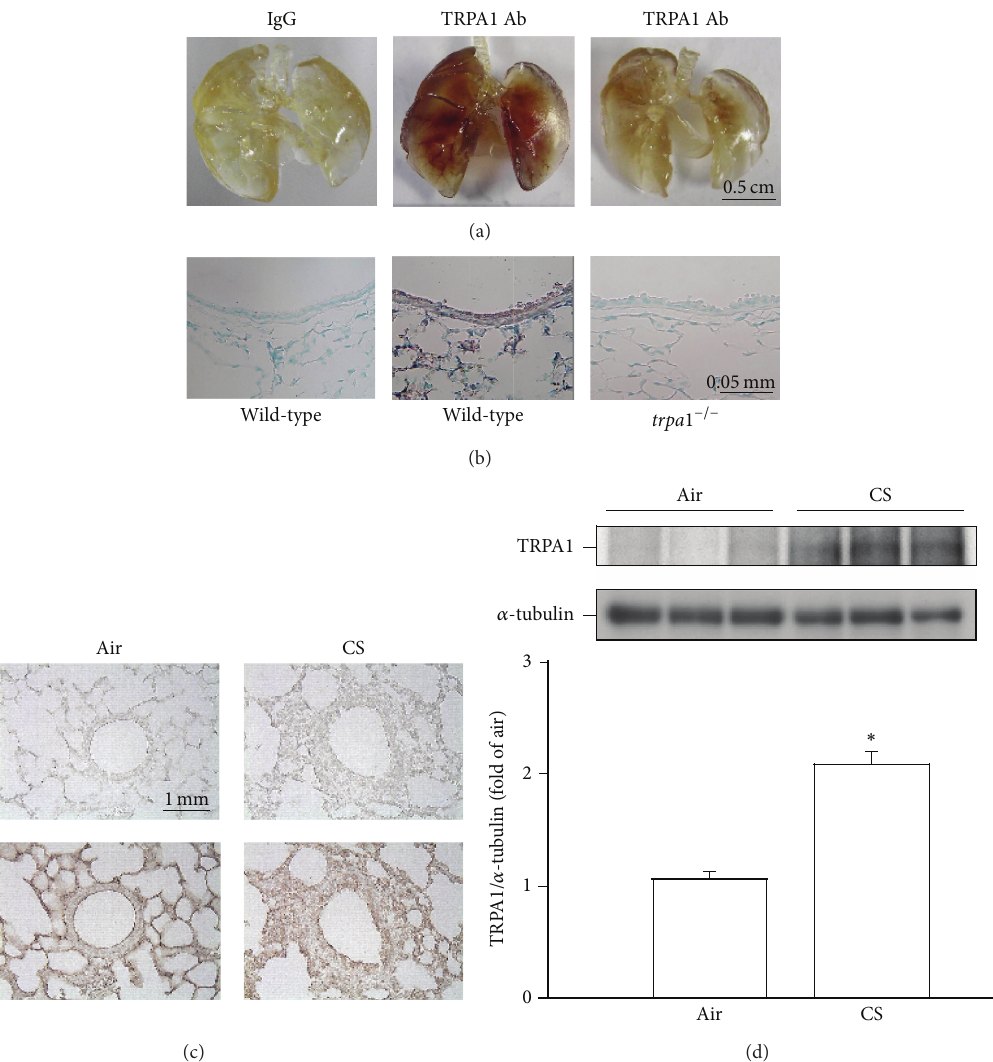
Figure 6: Cigarette smoke (CS) increases the lung expression of TRPA1 in mice. Mice were chronically exposed to air or CS for 4 weeks. (a) Representative images showing en face immunostaining with a TRPA1 antibody using whole lungs obtained from air-exposed wild-type mice and from trpa1 −/− mice. (b) Representative images showing lung section obtained from the lungs with the en face TRPA1-immunostaining of air-exposed wild-type mice and trpa1 −/− mice. (c) Representative images showing immunostaining with a TRPA1 antibody of representative lung sections obtained from air-exposed and CS-exposed wild-type mice. The specificity of the immunostaining was confirmed using an IgG-negative control. (d) Expression levels of TRPA1 in lung tissues were obtained from air-exposed and CS-exposed wild-type mice and were analyzed by Western blotting. ∗ 𝑝 < 0.05 versus the air control group in both genotypes. Data in each group are mean ± SEM from nine